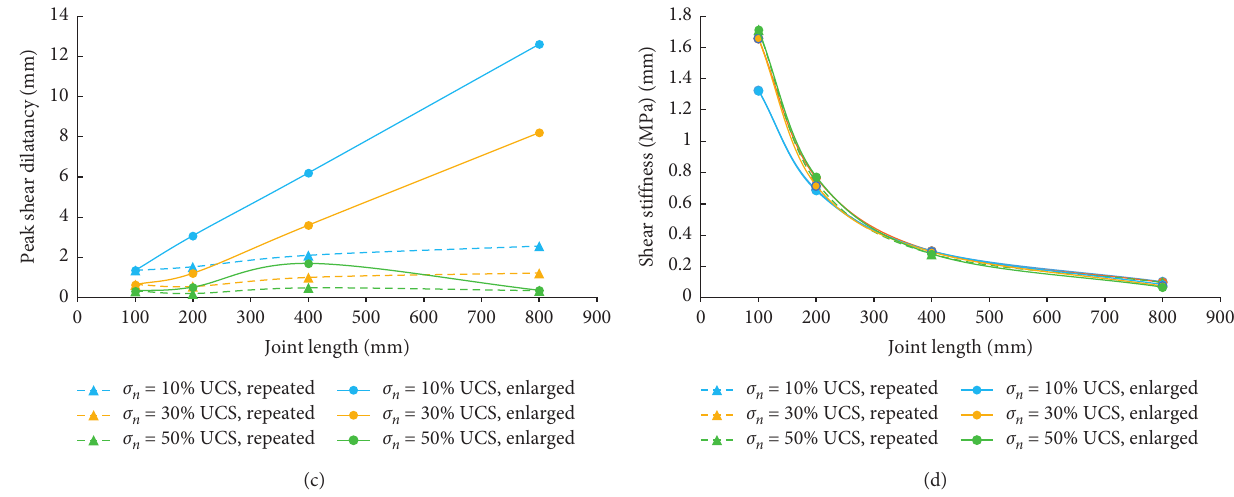
Figure 9: Shear behavior of different-sized repeated and enlarged joints under CNL condition. (a) Peak shear strength. (b) Peak shear displacement. (c) Peak shear dilatancy displacement. (d) Shear